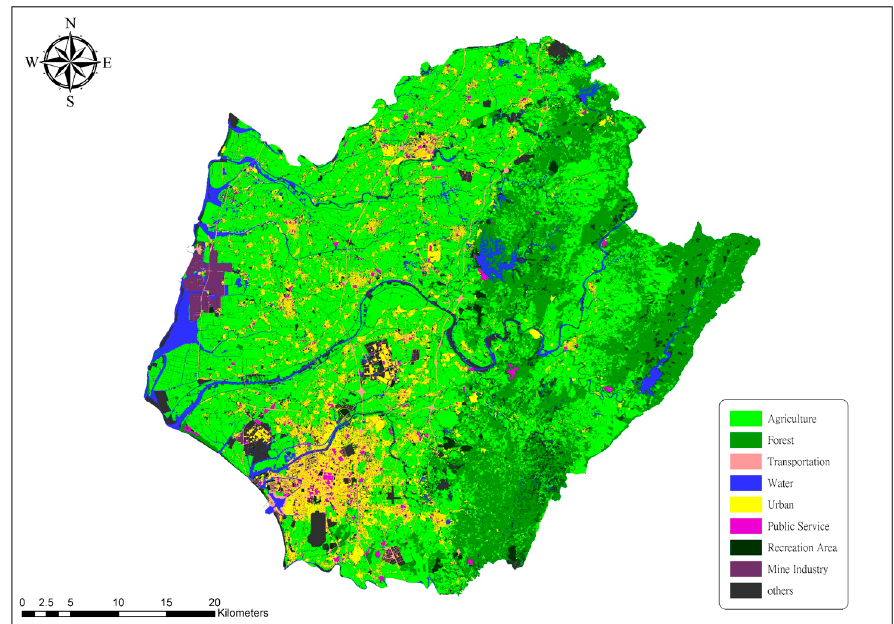
Figure 6. Land use in Tainan City.